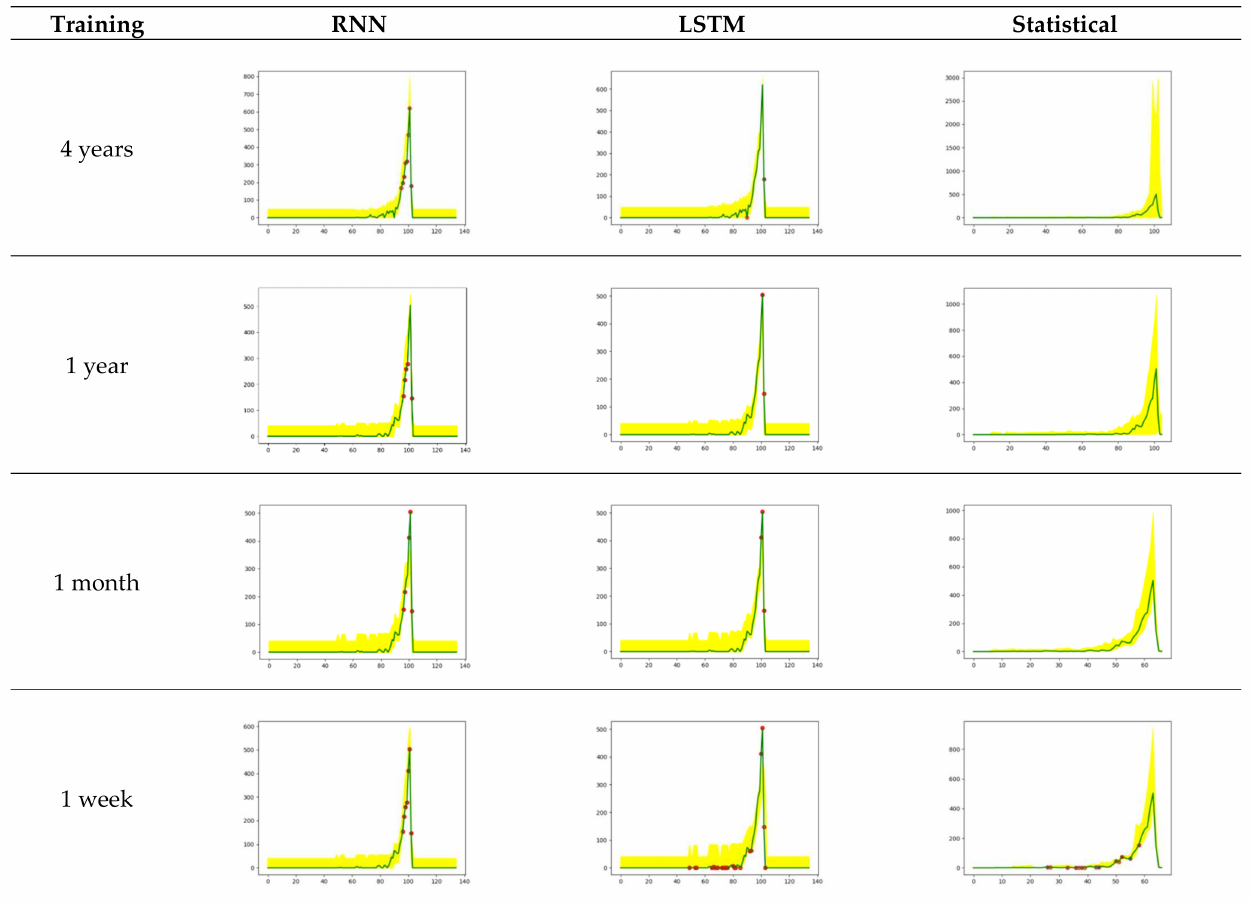
Figure 8. Anomaly detection of sample branch using RNN, LSTM, and statistical